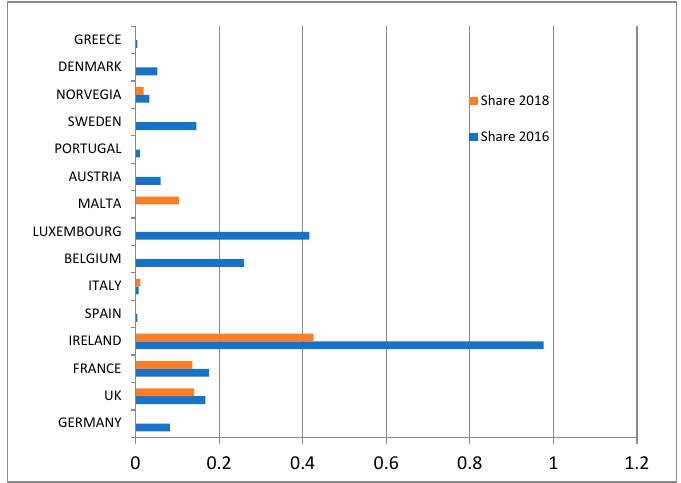
Figure 7. The share of migrant physicians from Romania in the total number of physicians from the destination country.